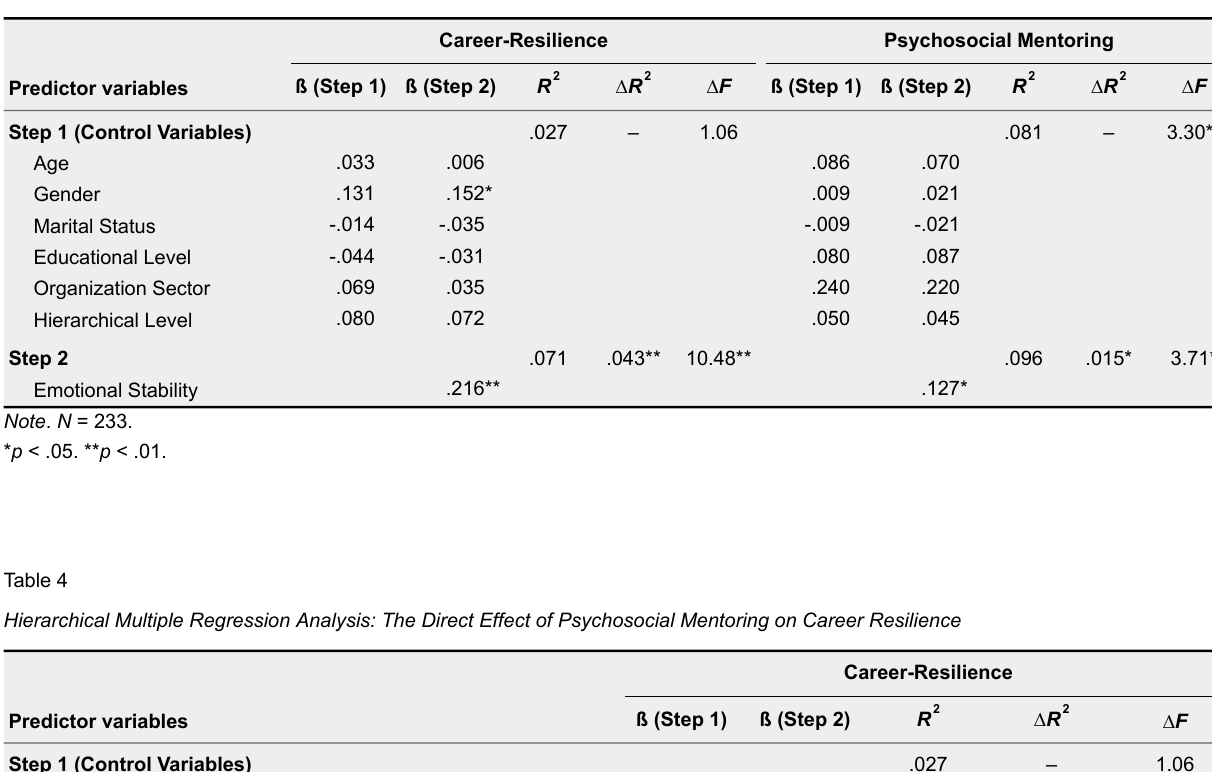
Hierarchical Multiple Regression Analysis: Direct Effects Between Emotional Stability and Career Resilience; Emotional Stability and Perceived Psychosocial Mentoring